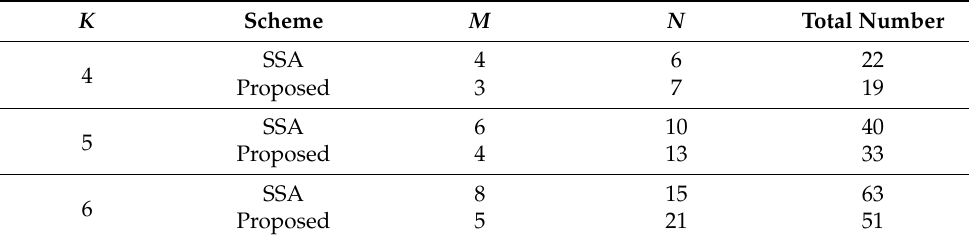
Table 4. Antenna configuration conditions of different